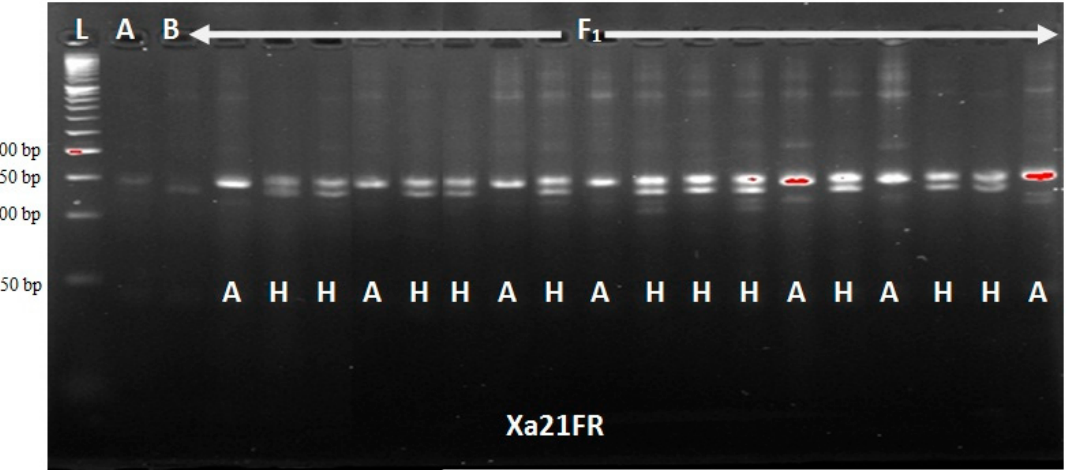
Figure 1. Foreground selection of F 1 hybrids using Xa21FR functional marker.